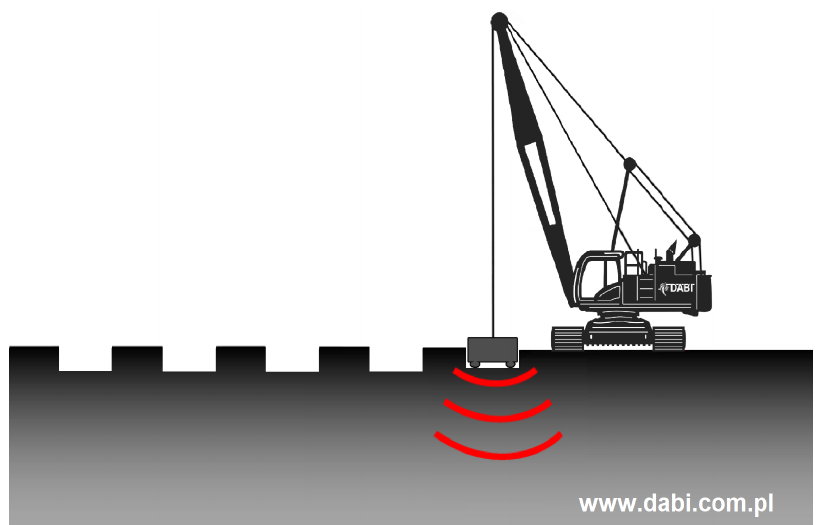
Figure 15. Graphics showing the technology of DC dynamic compaction (heavy compaction, graph. by P. Dobrzycki).